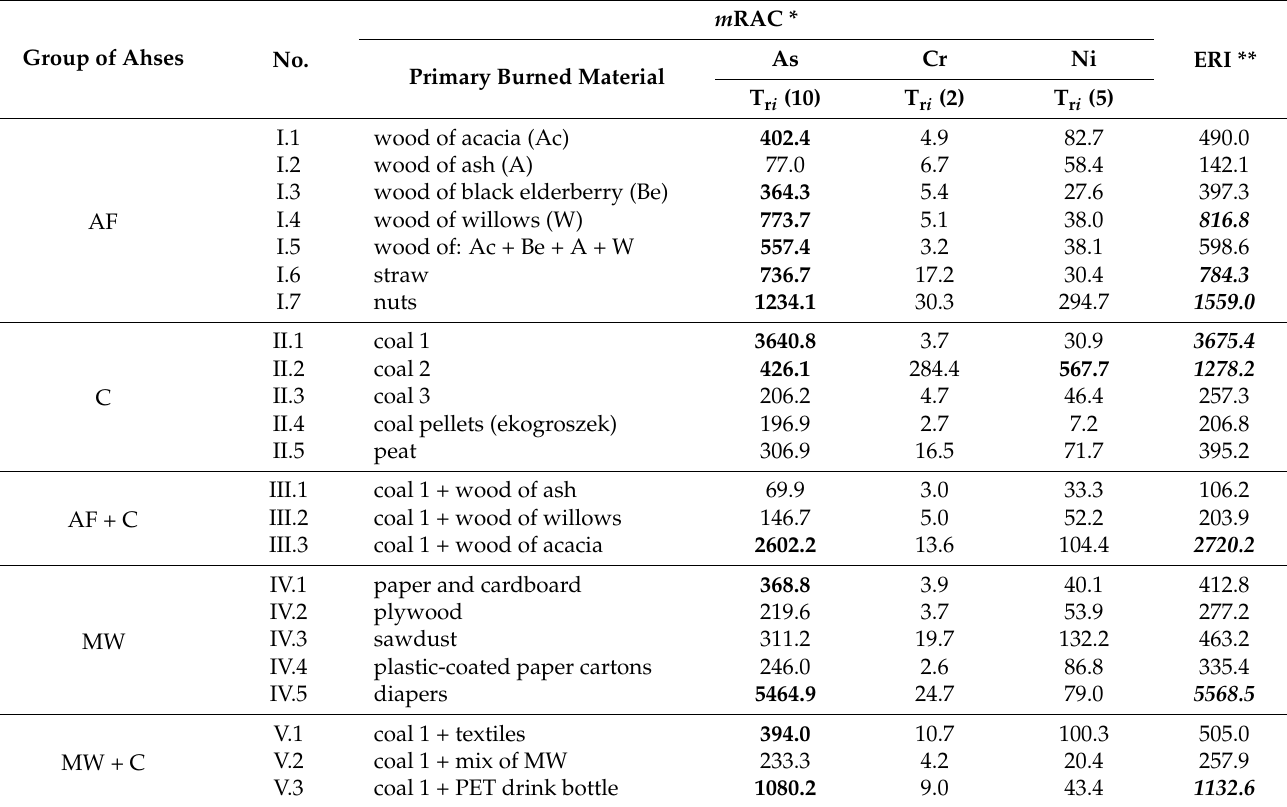
Table 6. Modified Risk Assessment Code ( m RAC) and potential Ecological Risk Index (ERI) calculated for household